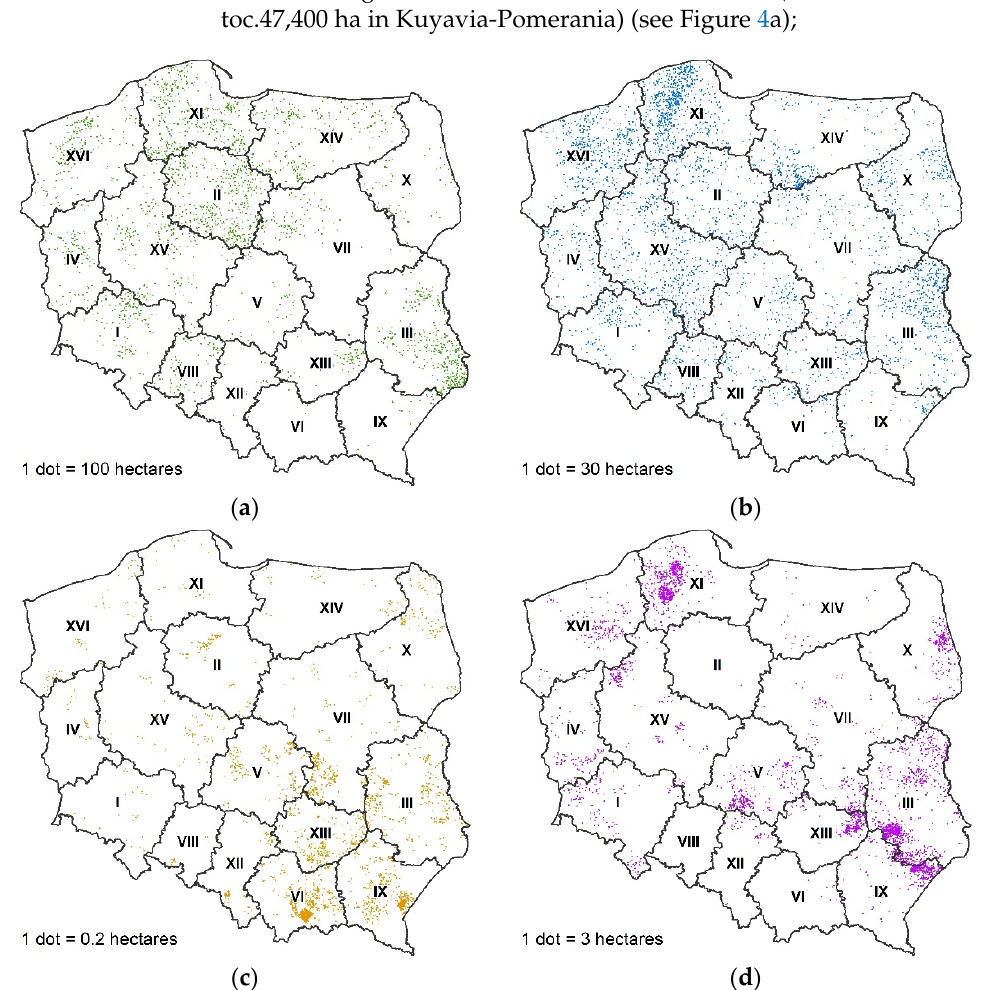
Figure 4. Land subsidised to support environmental agriculture, in ha ( a )—sustainable agriculture, ( b )—protection of soils and waters, ( c )—preservation of orchards with traditional varieties of fruit trees, ( d )—preservation of endangered plant genetic resources in agriculture).Source: own elaboration.